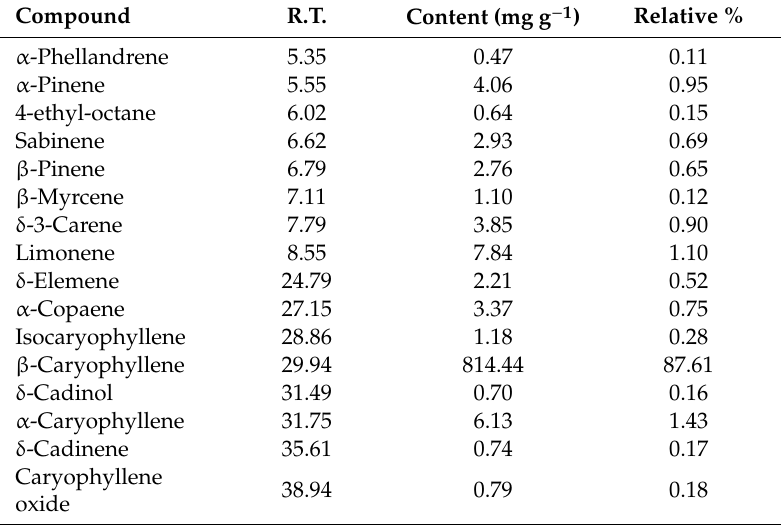
Table 1. Chemical composition of PipeNig ® -FL by gas chromatography coupled to mass spectrometry. Content is calculated based on gas chromatography with flame-ionization detection (GC–FID) analysis. R.T., retention